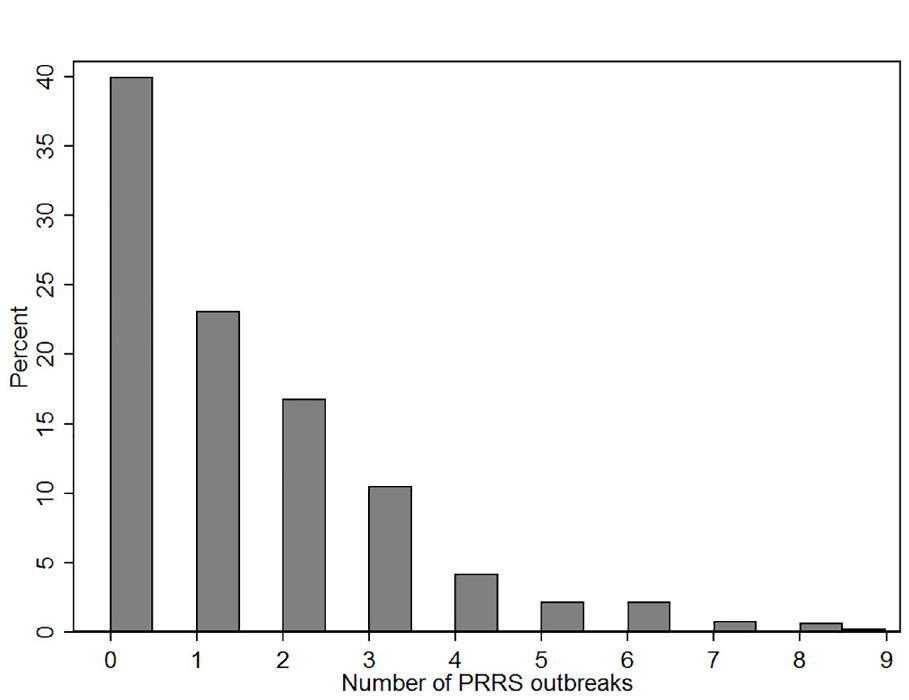
Fig 5. Histogram of distribution of PRRS outbreaks for all swine sites enrolled in the study over the years2009–2016.